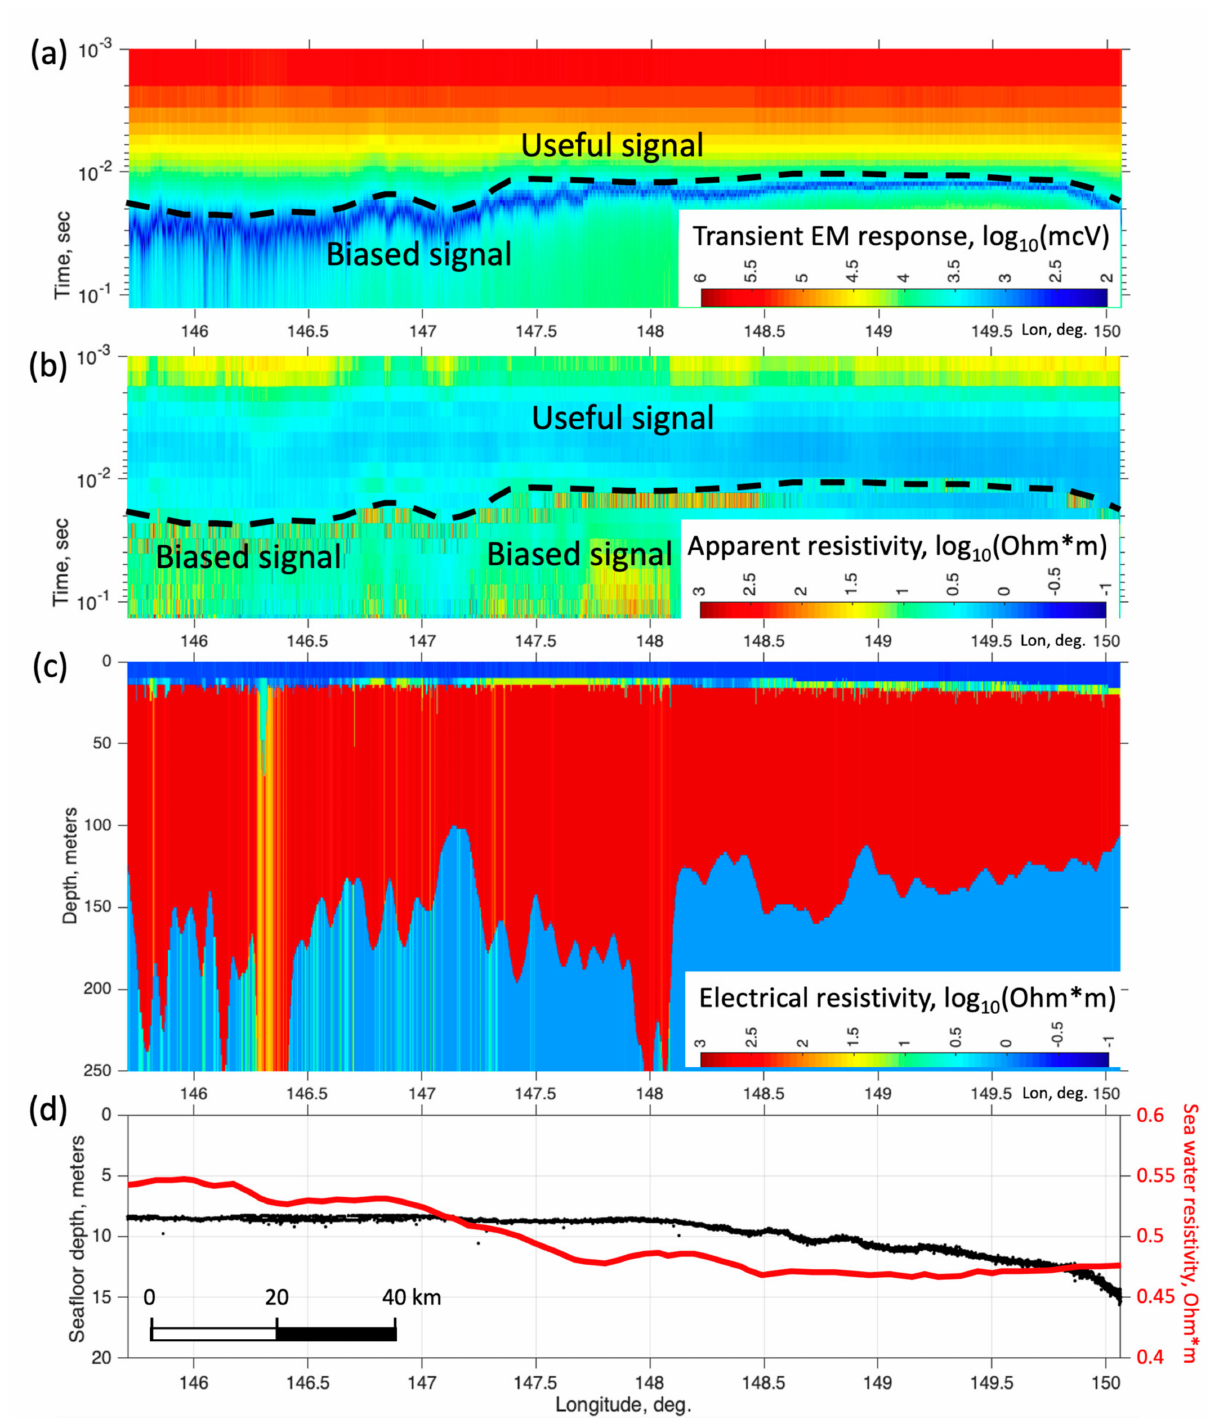
Figure 15. Examples of TDEM data recorded in the Laptev Sea southeast of Bolshoy Lyakhovsky Island. Raw decay voltage and processed apparent resistivity pseudosections (logarithmic color scale) are presented in panels ( a , b ), respectively; the dashed line corresponds to the transient time where responses start to exhibit unrealistically-high de-cay rate caused by low-frequency noise, and marks the boundary between the useful signal at earlier times and the distortion-affected region; panel ( c ) shows inverted resistivity model, with the dark-red region being the permafrost layer, and ( d ) indicates the seafloor depth (black) and surface water resistivity (red) along the line